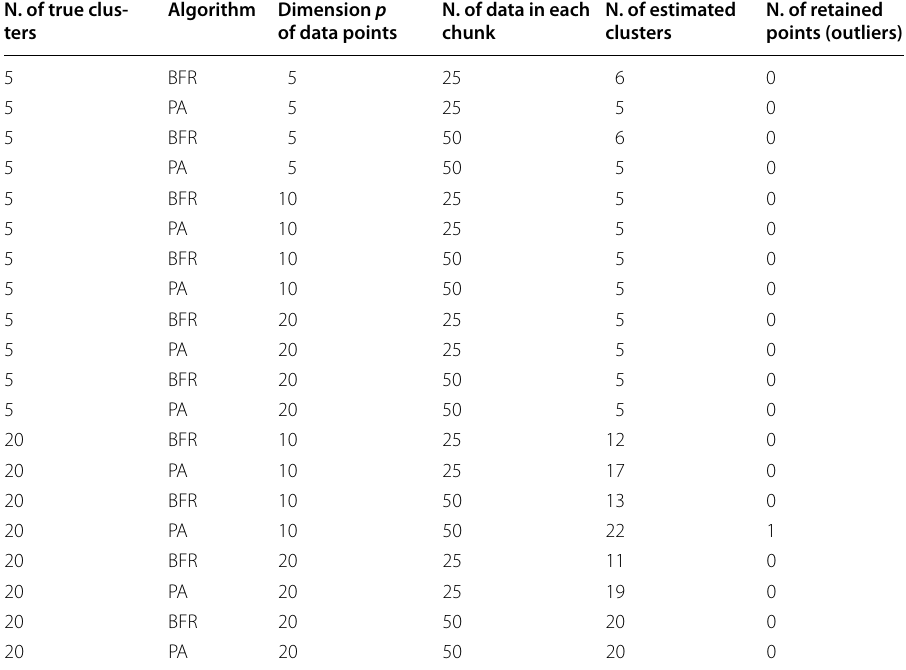
Table 1 Results of the application of our proposed algorithm (PA) and of the BFR algo- rithm to synthetic